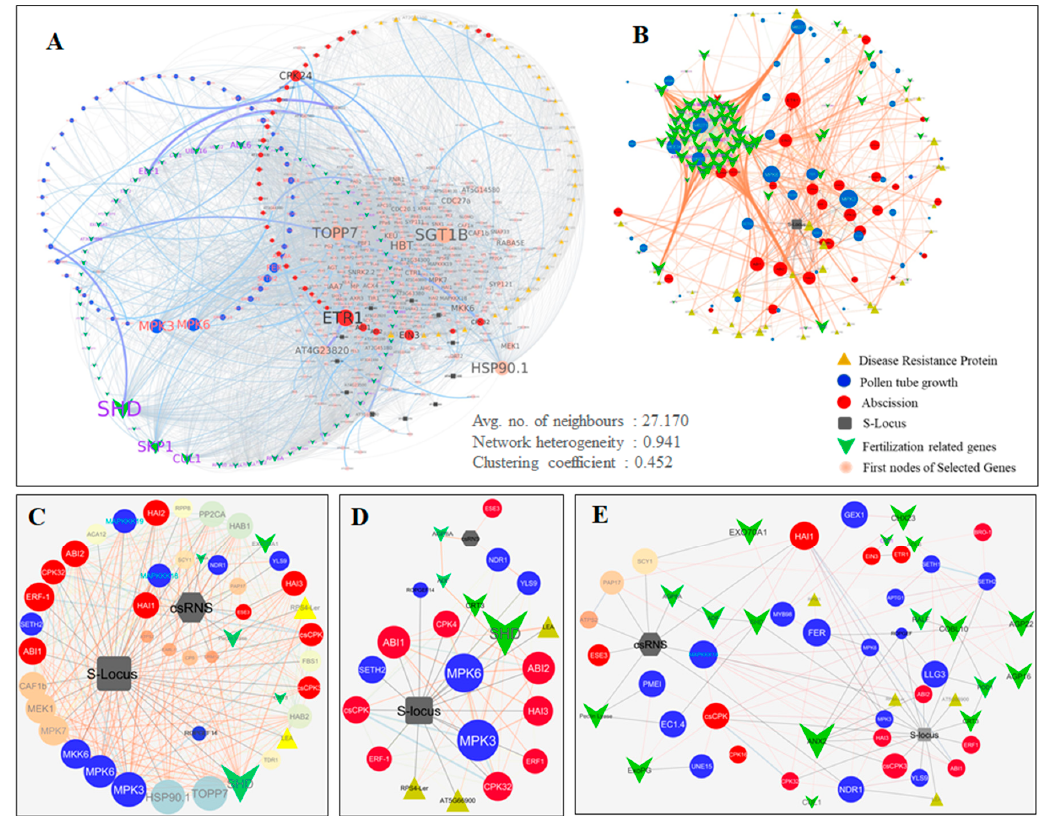
Figure 3. Predicted protein-protein interactome network of DE transcripts involved in fertilization or Self-Incompatibility in tea. ( A ) A major hub of 182 genes interacting with 343 first neighbors (6598 edges), ( B ) Co-expression network of 169 genes (1417 edges) extracted from 182 genes. ( C ) Gene specific predicted PPI-interactome network of S-Locus group (SRKs) and cs RNS (C. sinensis). ( D ) Direct interactions of S-locus related group and S-RNase. ( E ) Direct and indirect interactions of transcripts encoding genes involved in SI and Fertilization.